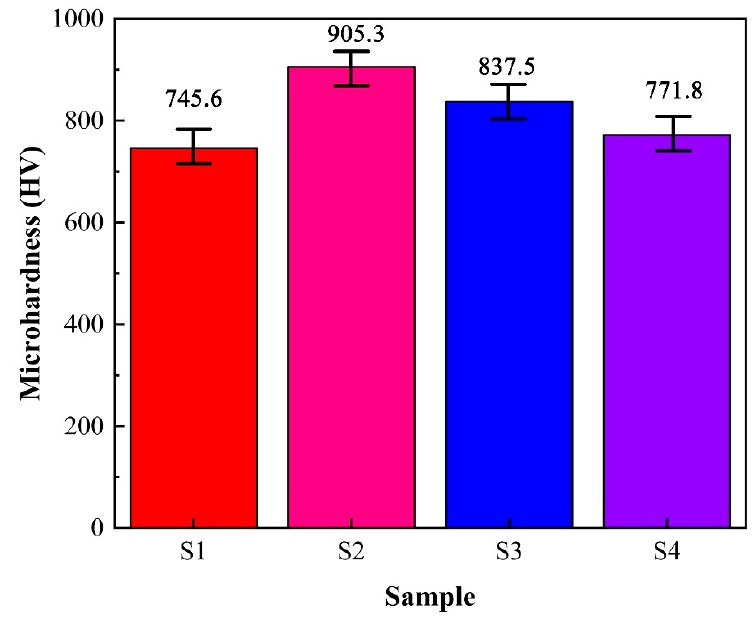
Figure 6. Microhardnesses of Ni/W-SiC